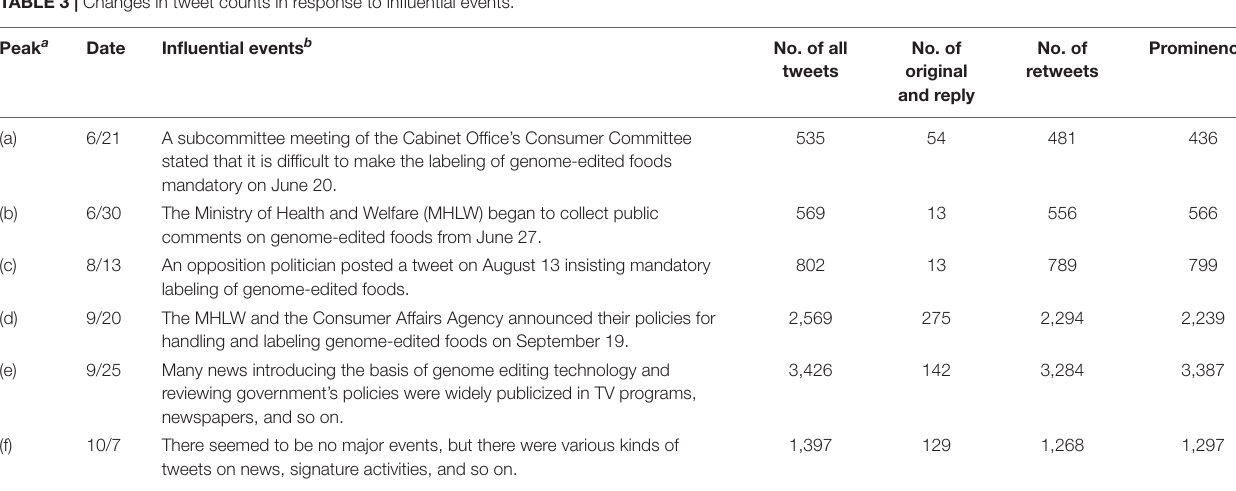
FIGURE 1 | Changes in the daily number of tweets. This figure shows the number of tweets in chronological order from May 15 to October 15. The bars represent the total tweet count including original tweets, reply tweets, and retweets. Prominence of peaks (a–f) were identified with Python (version 3.7.6) using the SciPy 1.4.1. TABLE 3 | Changes in tweet counts in response to influential